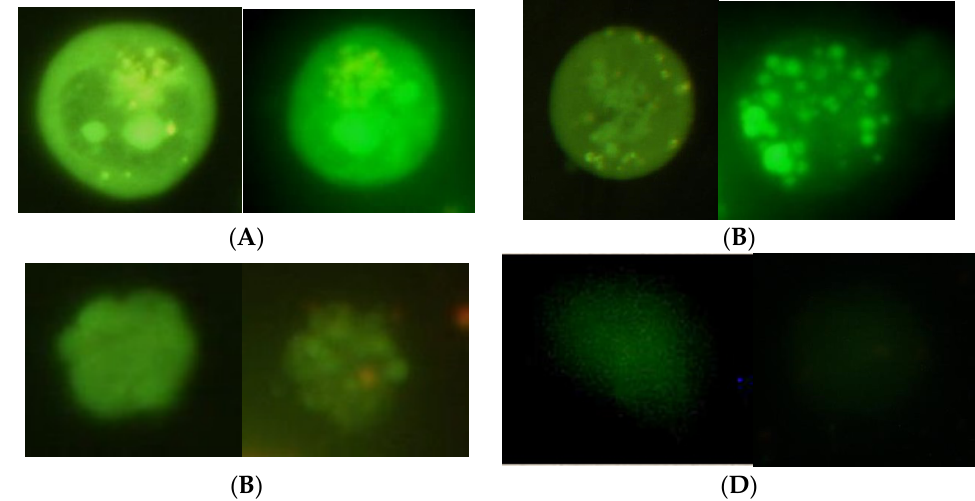
Figure 1. External view of live and dead cells in microslides dyed by acridine orange (( A )-living cell, ( B )-apoptosis (early stage), ( C )-apoptosis (late stage), ( D )-necrosis). To analyze the DNA damage, the DNA comet method was applied, similarly to [34]. The Casplab_1.2.3b2 software was used to calculate the percentage of the DNA in the “comet tail” (Figure 2).